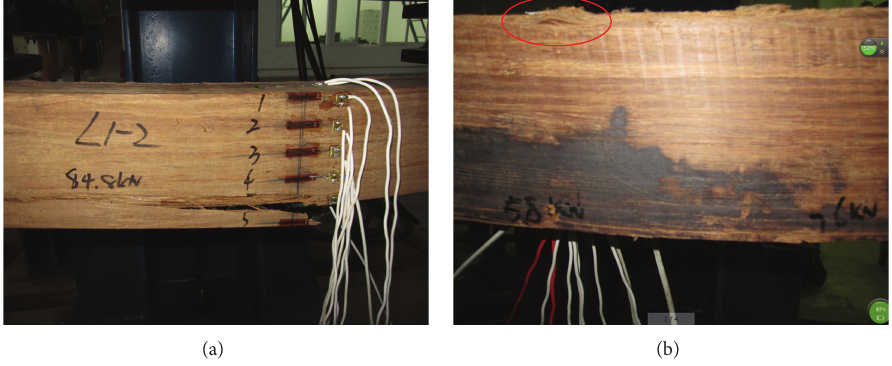
Figure 2: Failure modes of specimens.